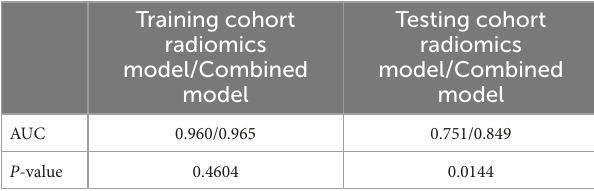
TABLE 5 Delong test